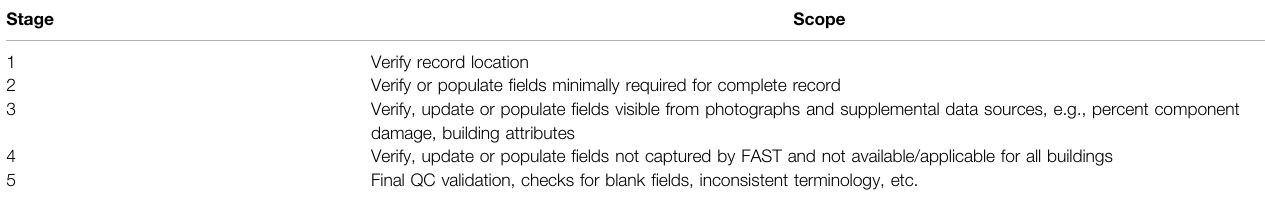
TABLE 3 | Stages of DEQC Process.